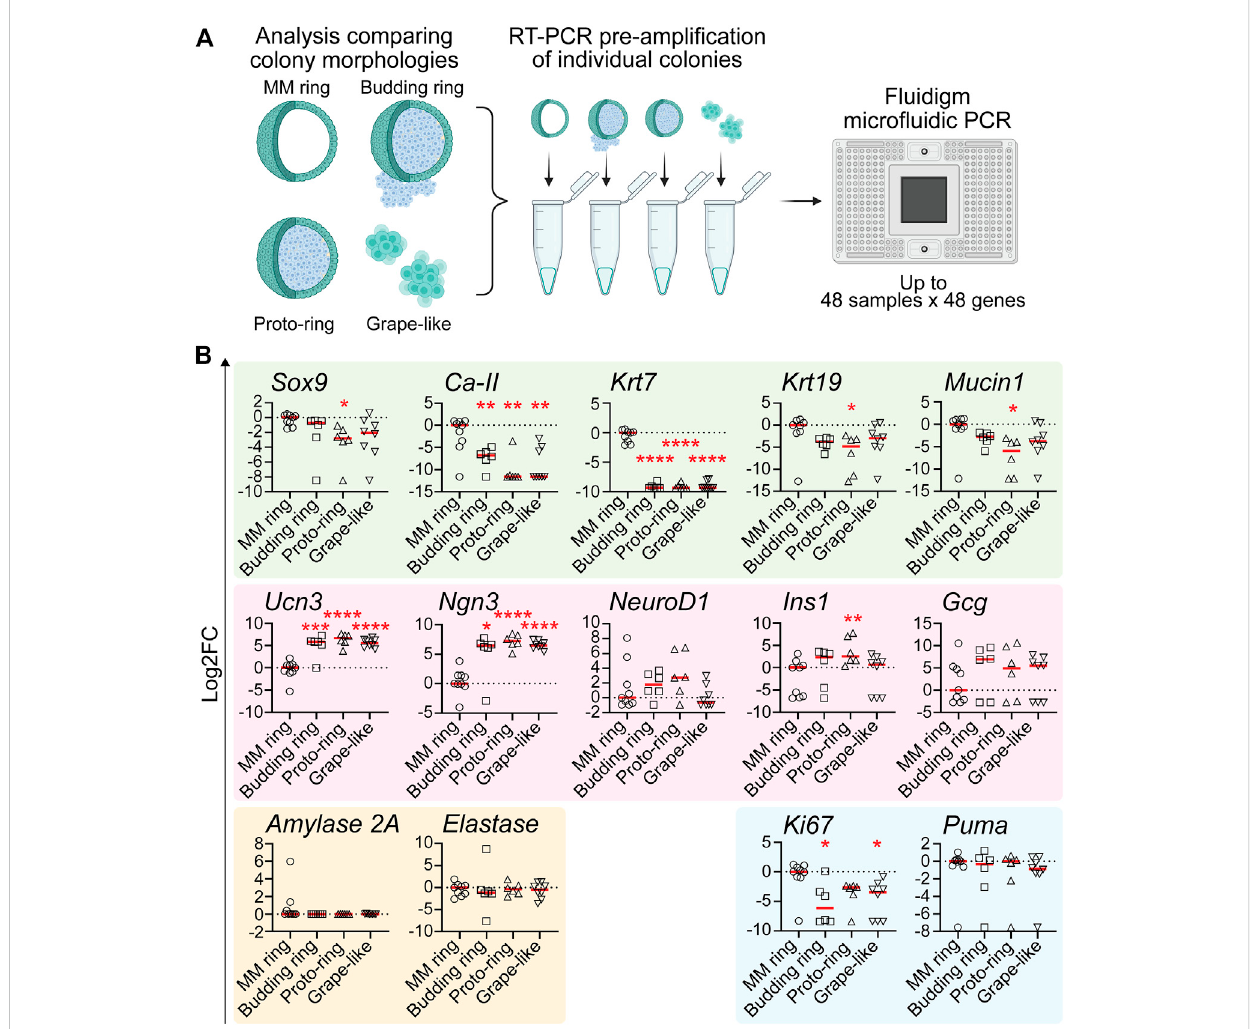
FIGURE 4 Pancreaticcolonieswithmorphologyof “ buddingring ” , “ proto-ring ” or “ grape-like ” expresshigherlevelsofendocrineandendocrineprogenitorcell markers and lower levels of ductal cell markers (A) Experimental scheme. The procedures were the same as explained in Figure 3A, except that the morphology of each colony was also identi fi ed and recorded when visualized under a light microscope before performing pre-ampli fi cation and micro fl uidic PCR (B) Gene expression analysis using micro fl uidic qRT-PCR on individual colonies with various morphologies. Data were fi rst analyzedrelativetotheinternalcontrolhousekeepinggene,B2M.Subsequently,thedataweretransformedintoLog 2 scaleandnormalizedtothemedian expression of the colonies with the MM ring morphology. Student ’ s t-test with Welch ’ s correction was used to determine the signi fi cance of the values between variousmorphologies vs. MM ring. Data were derived from a total of six to nine colonies of each morphology. Each dot represents a colony and red line represents the median. Red asterisks indicate statistical signi fi cance when compared against the control MM ring morphology: * p < 0.05, ** p < 0.005, *** p < 0.005, and **** p <